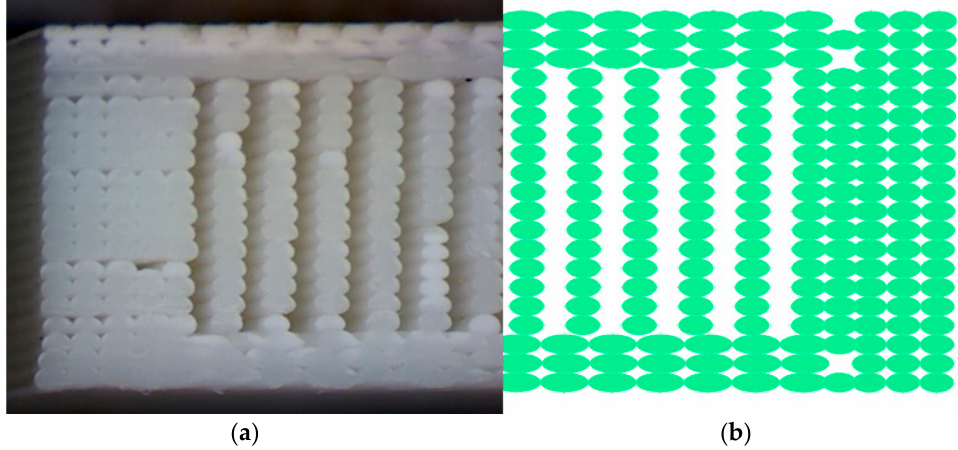
Figure 5. Cross-section comparison of the fiber structure between a printed tensile specimen and the geometrical model in ANSA: ( a ) printed specimen under microscope; ( b ) geometrical model.